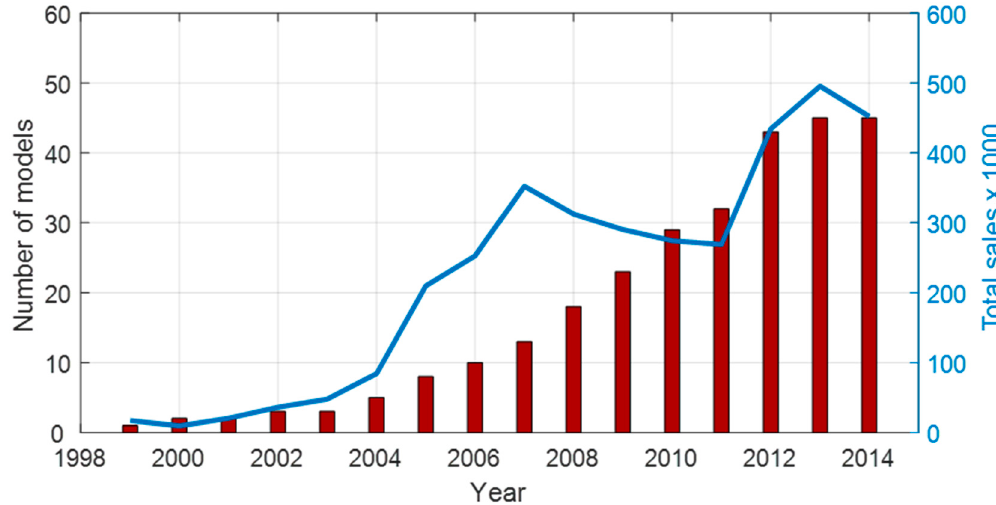
Figure 9. Number of hybrid vehicle models and total sales (Data from [62]).